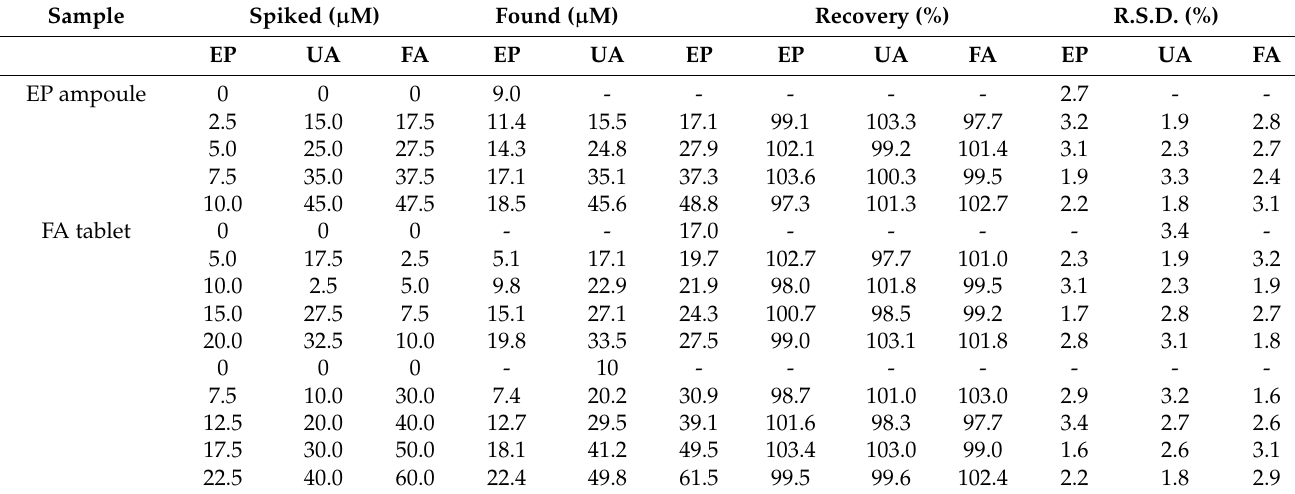
Table 2. The use of 2FTNEMCNPPE in simultaneous quantification of EP, UA and FA in an EP ampule, an FA tablet and urine samples (n = 5). The amounts of EP and FA in ampoules and tablets were found to be equal to 0.98 mg mL − 1 and 1.01 mg/tablet, respectively. These outcomes show no significant difference between the results of the 2FTNEMCNPPE and the nominal value on the ampoule label and tablet label (1.00 mg mL − 1 and 1.00 mg/tablet, respectively) [50].